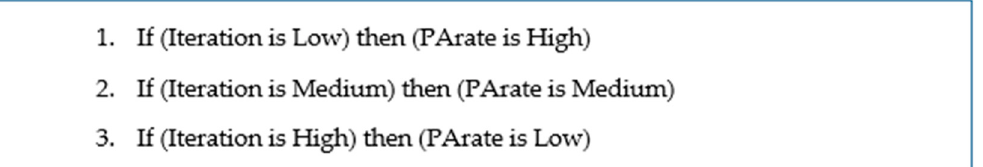
Figure 11. Rules for Fuzzy System 2 to Decrease (FHS2).